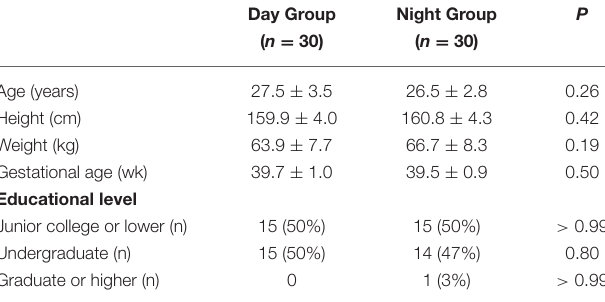
Frontiers in Medicine |